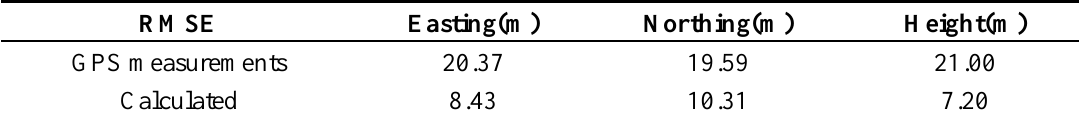
Table 3. RMSE of GPS measurements and system calculated positions using surveyed values as true values.